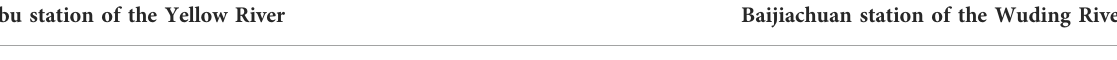
TABLE 4 Summary of prototype cases — Guxian Reservoir. Wubu station of the Yellow River